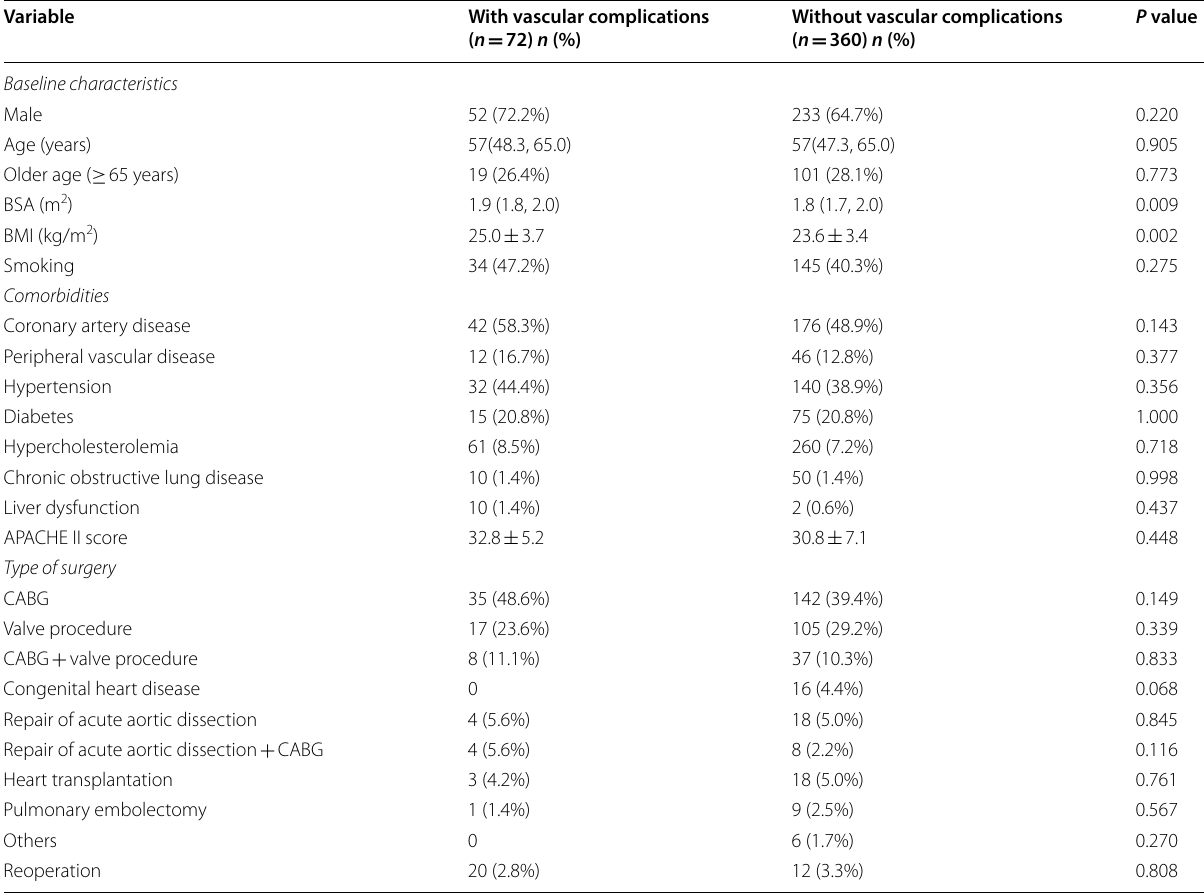
Table 1 Patient demographics, comorbidities, and surgical